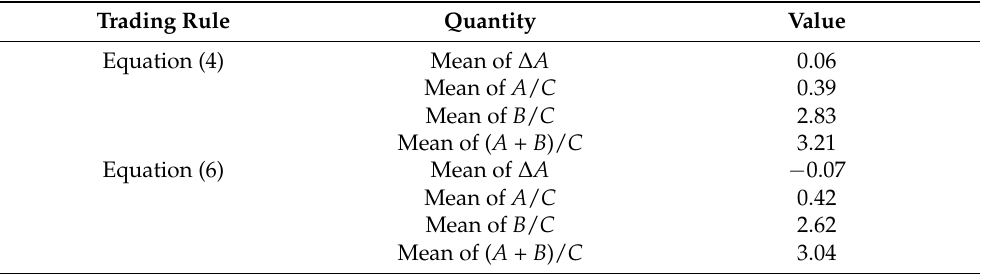
Table 4. Mean of ecosystem services loss ∆ A over 10,000 model parameter combinations, and mean of the benefit–cost ratios A / C and B / C ( A + B )/ C for the ES a and b . Obtained for the two credit trading rules of Equation (4) and Equation (6), respectively.